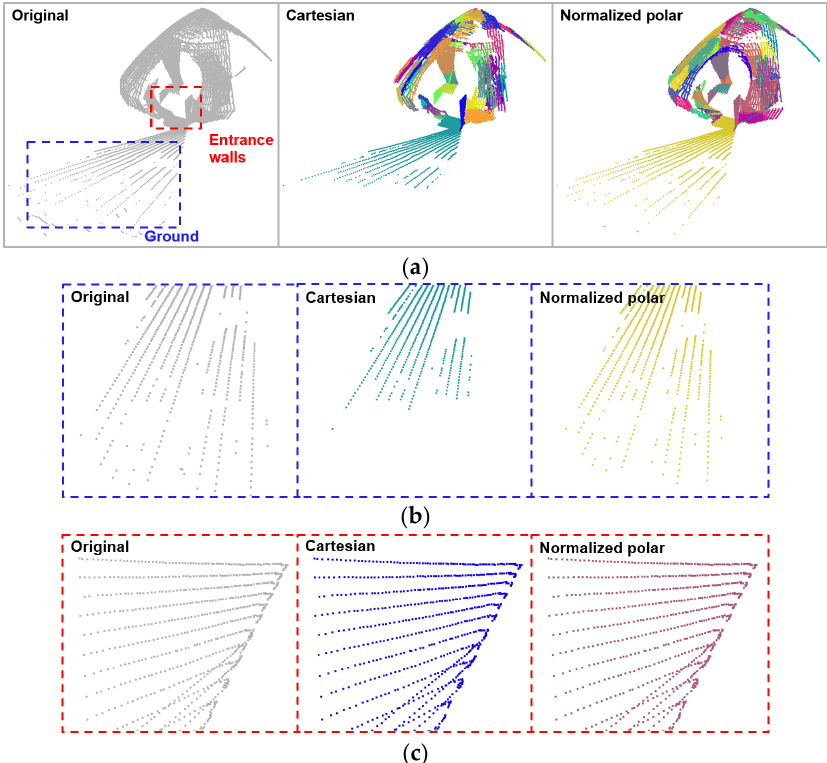
Figure 24. Planar feature segmentation results: ( a ) comparison of segmentation results based on Cartesian and normalized polar coordinates of the original point cloud (ground and entrance walls are highlighted in blue and red dotted boxes, respectively), ( b ) zoom-in window of the ground feature, and ( c ) zoom-in window of the entrance wall feature.